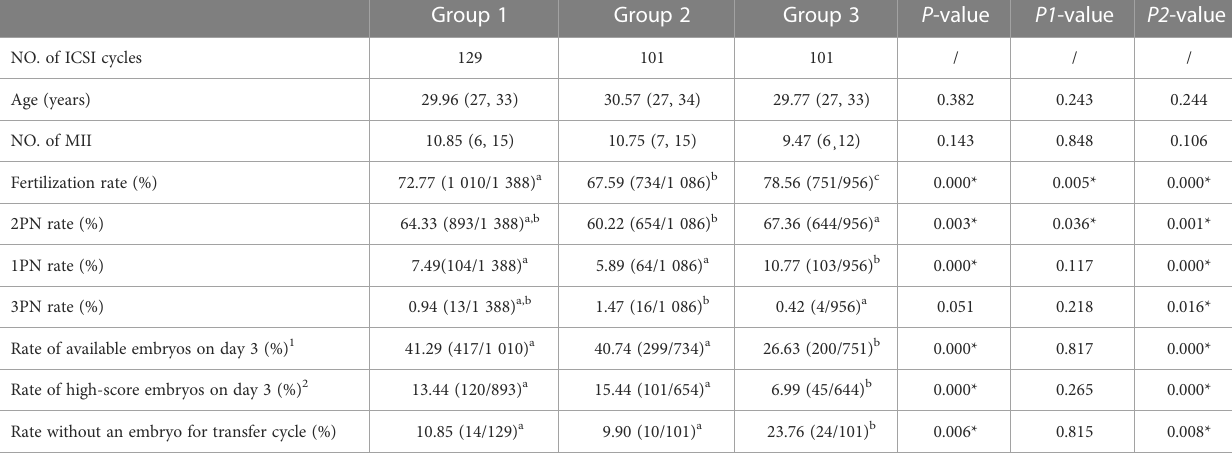
TABLE 2 Comparison of the ICSI outcomes between AOA and non-AOA after motile or immotile sperm